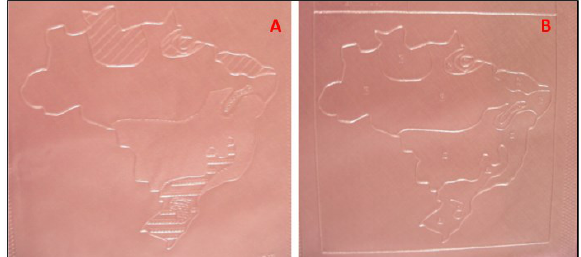
Figure 10. Tactile map layout of Brazilian Climates with Braille letters. Source: Adapted from Nogueira [Loch], 2008.